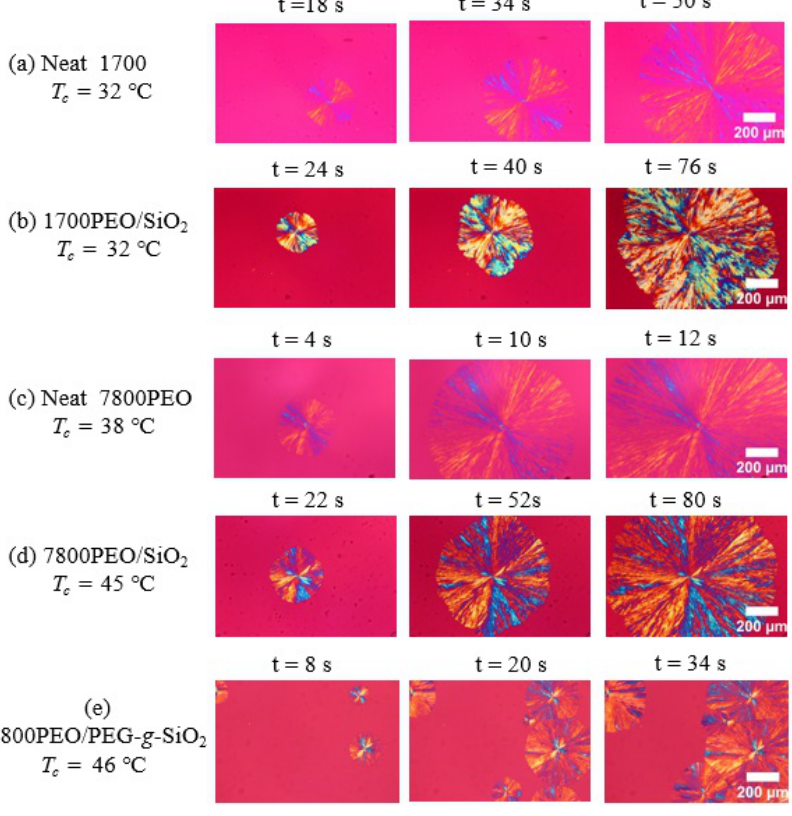
Figure A4. Spherulitic growth studied by PLOM isothermally crystallized at different T c . ( a ) neat1700 PEO, ( b ) 1700PEO/SiO 2 , ( c ) neat 7800PEO, ( d ) 7800PEO/SiO 2 , ( e ) 7800PEO/PEG-g-SiO 2 .